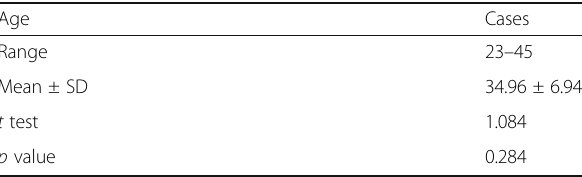
Table 1 Distribution of the studied cases according to the age